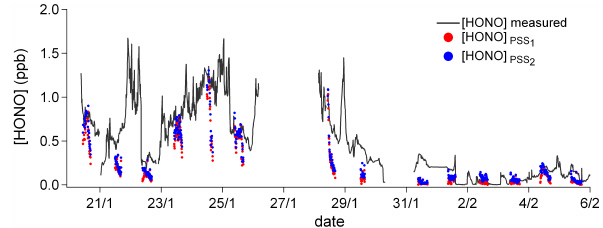
Fig. 7. Observed HONO mixing ratios (black lines) compared with PSS calculations (red circles for Eq. 1 and blue circles for Eq. 2) for the MEGAPOLI winter campaign. The calculations with the PSS approach are carried out only when all the parameters used in it are available.